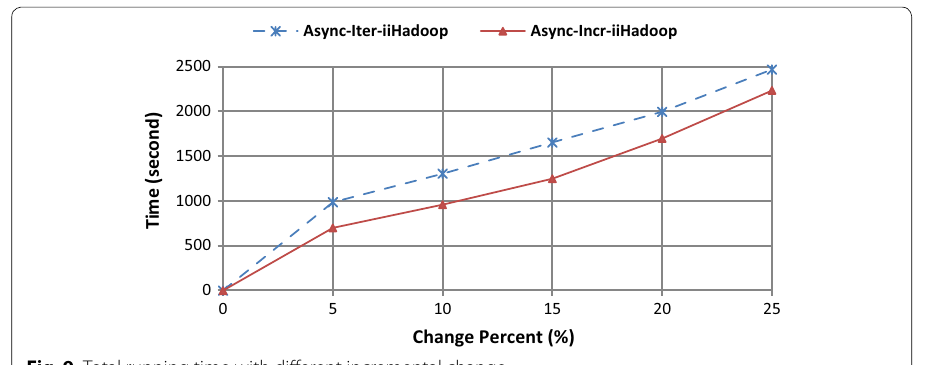
Fig. 9 Total running time with different incremental change